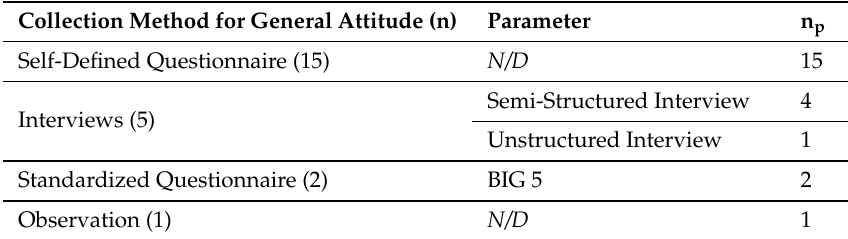
Table 6. General Attitude collection methods and parameters.